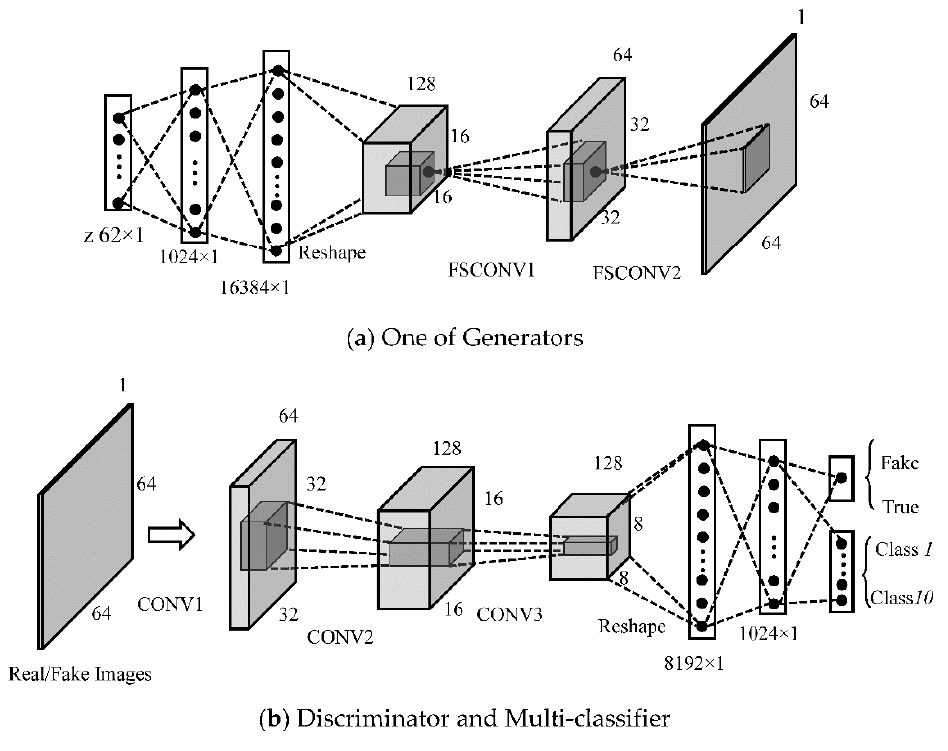
Figure 3. Architecture of the MCGAN for 64 × 64 SAR images: ( a ) One of Generators and ( b ) Discriminator and Multi-classifier.